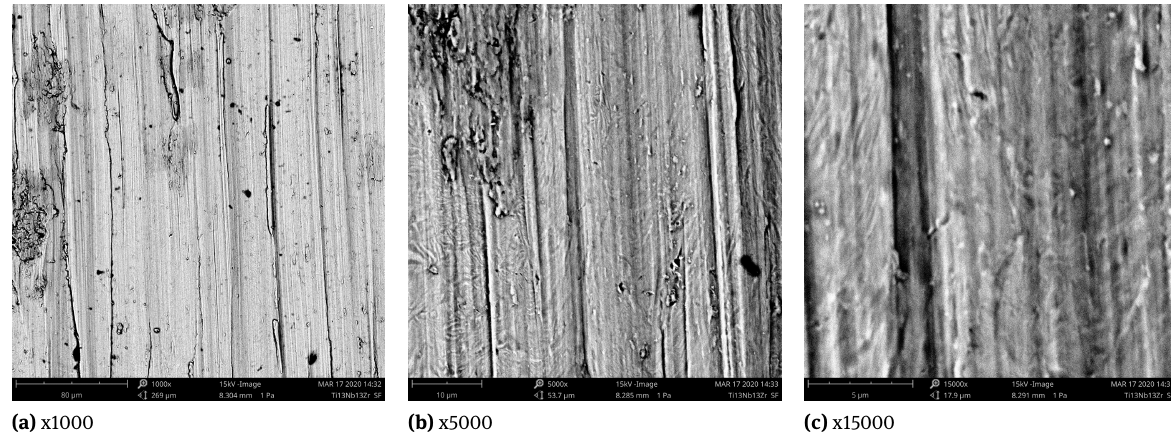
Figure 10: Surface morphology of the wear traces after friction with synovial fluid (SF) for